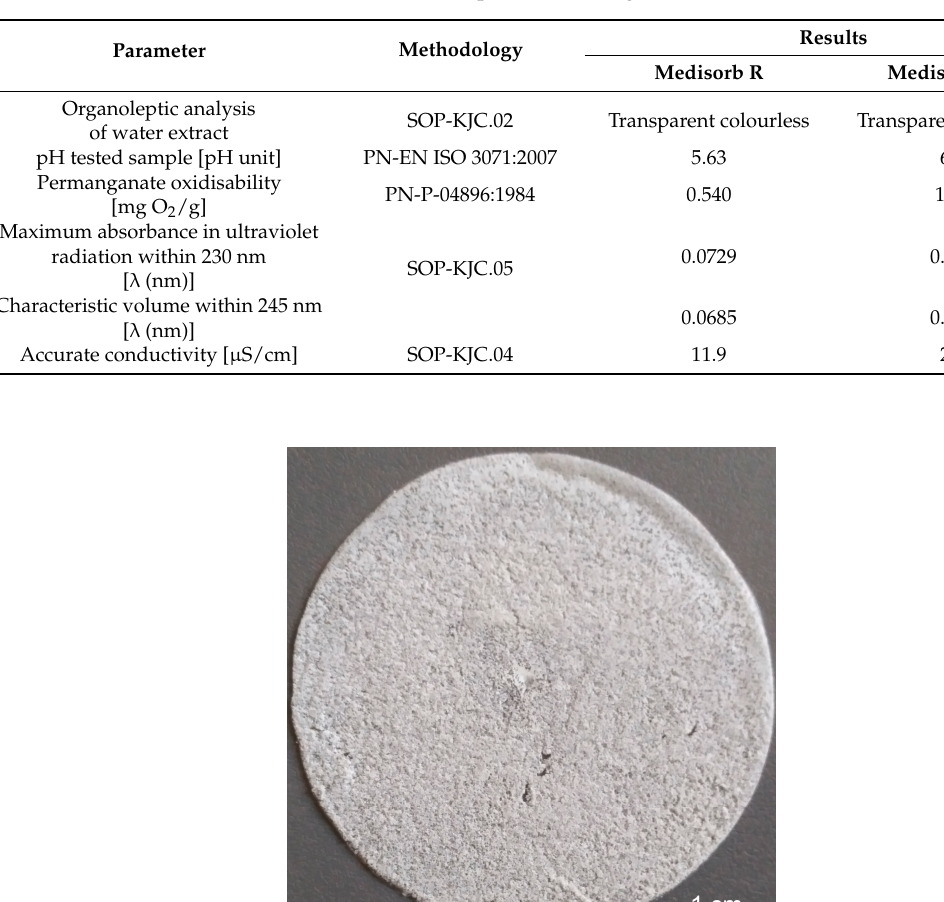
Table 6. Chemical test results of porous dressing materials, Medisorb series.